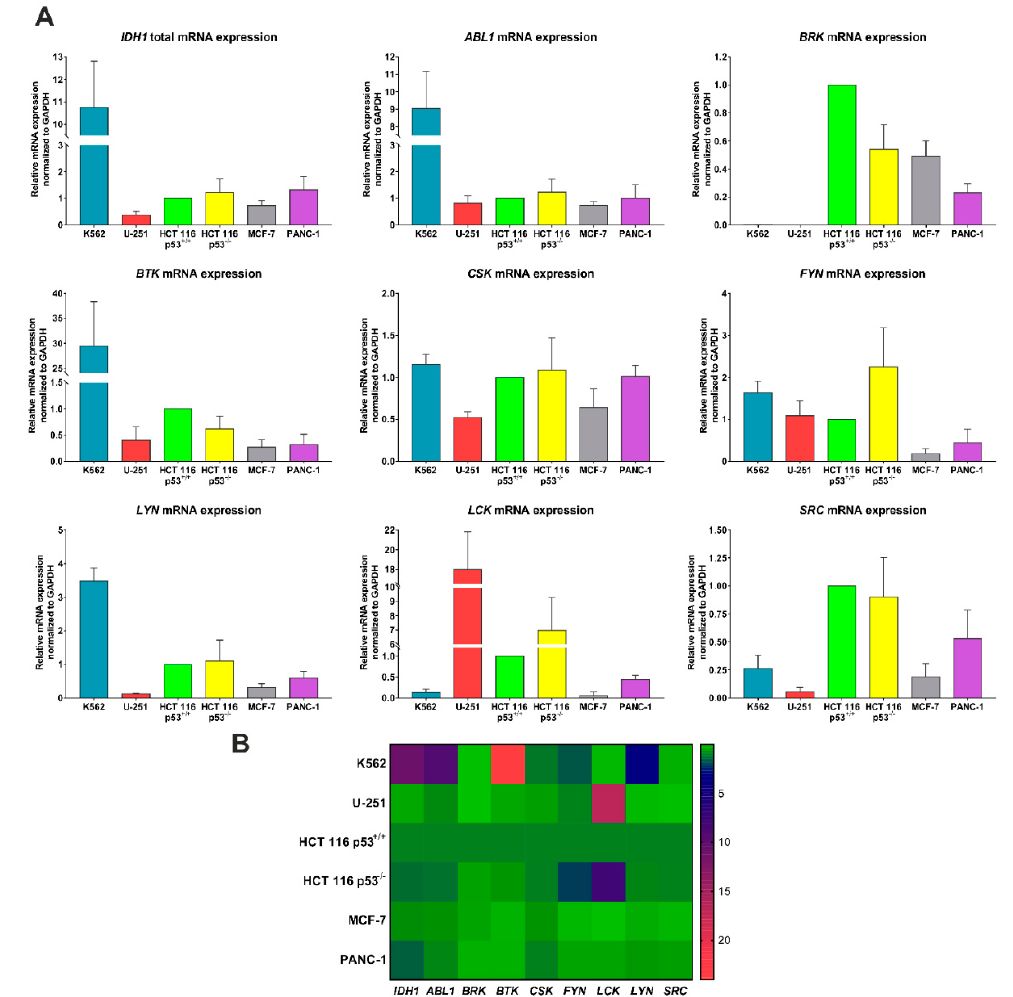
Figure 5. mRNA expression of the IDH1 , ABL1 , BTK , BRK and Src family tyrosine kinases in the various cancer cell lines (K562, U-251, HCT 116 p53 +/+ , HCT 116 p53 - / - , MCF-7 and PANC-1). The results are shown as the mean ± SD of four independent measurements, each in triplicate. The data were normalized to the HCT 116 p53 +/+ (one value) ( A ). Heat map displaying the expression of IDH1 and the kinase landscapes in the tested cancer cell lines ( B ).